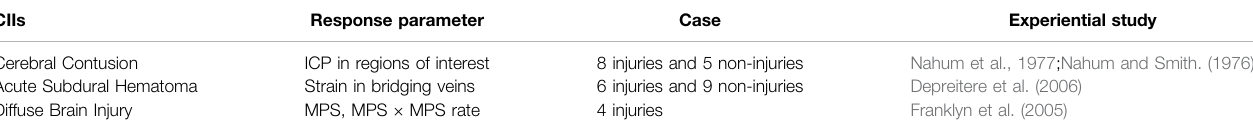
TABLE 4 | Cadaver test studies used to determine the